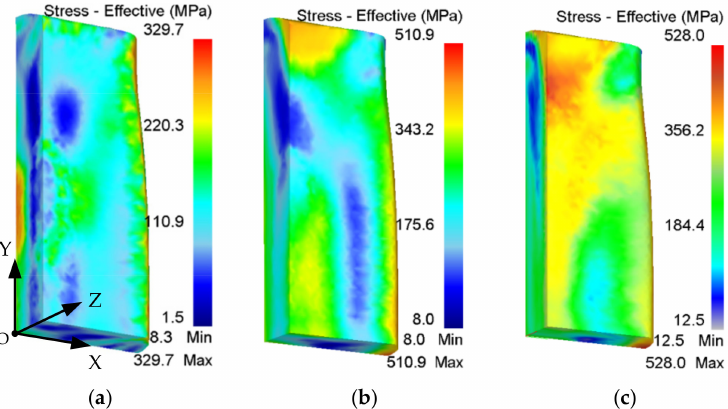
Figure 9. Simulation results of effective stress under T = 1020 ◦ C and V = 25 mm/s. ( a ) air-cooling, ( b ) oil-cooling, ( c )